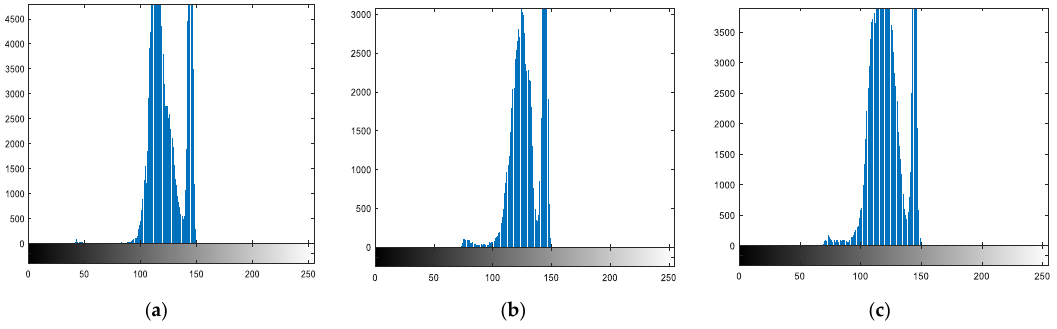
Figure 7. Histograms of ( a ) isolated cell, ( b ) touching cell, and ( c ) overlapped cell.